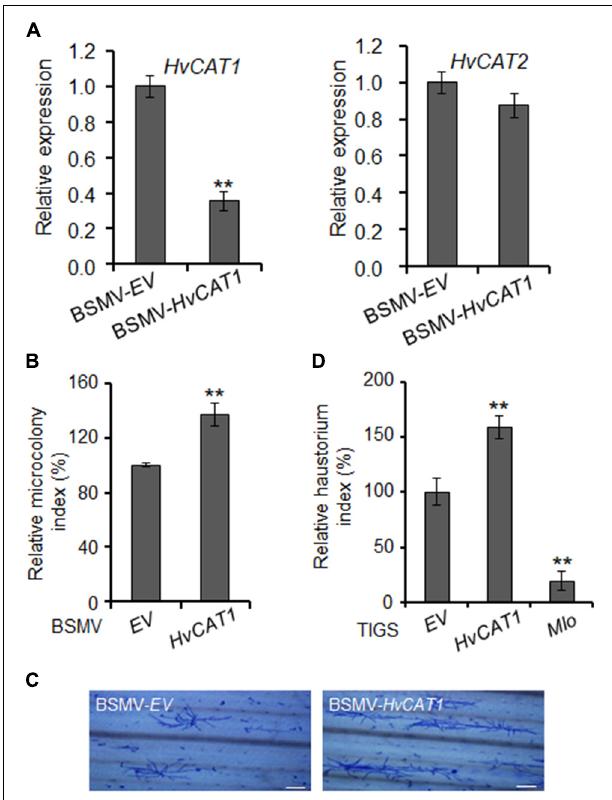
FIGURE 6 | Hv CAT1 is involved in barley immunity. (A) Barley stripe mosaic virus (BSMV)- Hv CAT1 specifically silenced the expression of HvCAT1 but not HvCAT2 . HvCAT1 (left) and HvCAT2 (right) gene expression levels were determined by qRT-PCR. (B) BSMV-VIGS of HvCAT1 affected barley immunity to Bgh . Bgh microcolony index was scored upon silencing of HvCAT1 in barley leaves by using BSMV- Hv CAT1 after inoculation with a compatible isolate BghA6 , and standardized to the BSMV-EV control that was reset to 100%. At least 1,000 interacting sites were microscopically evaluated in one experiment. (C) Representative pictures of Bgh microcolony and hyphae growth on barley leaf surface in BMSV-VIGS assays. Bar = 200 µ m. (D) Transiently-induced gene silencing (TIGS) silencing of HvCAT1 affected barley immunity to Bgh . Indicated RNAi construct was bombarded into barley epidermal cells, and Bgh haustorium index was scored and standardized to that of EV control. RNAi- Mlo construct was used as a control for silencing of Mlo that caused dramatic reduction of HI%. The data were presented as average ± SD from three representative replicates. * p < 0.05; ** p < 0.01, show significant difference by Student’s t